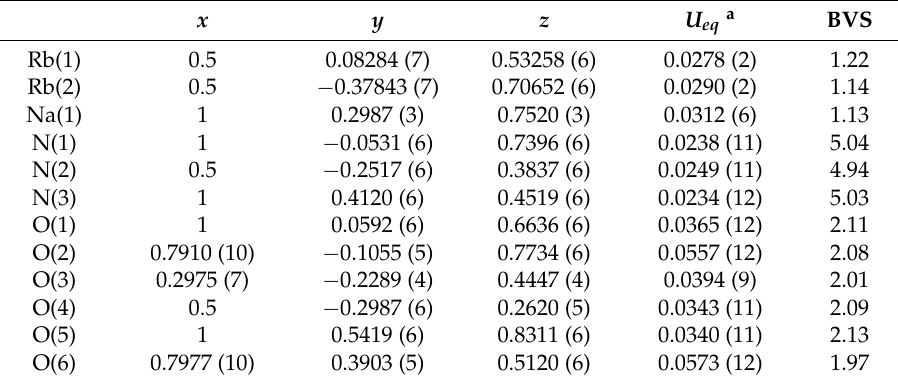
Table 3. Atomic Coordinates, Isotropic Displacement Parameters, and Bond Valence Sums for Rb 2 Na(NO 3 ) 3